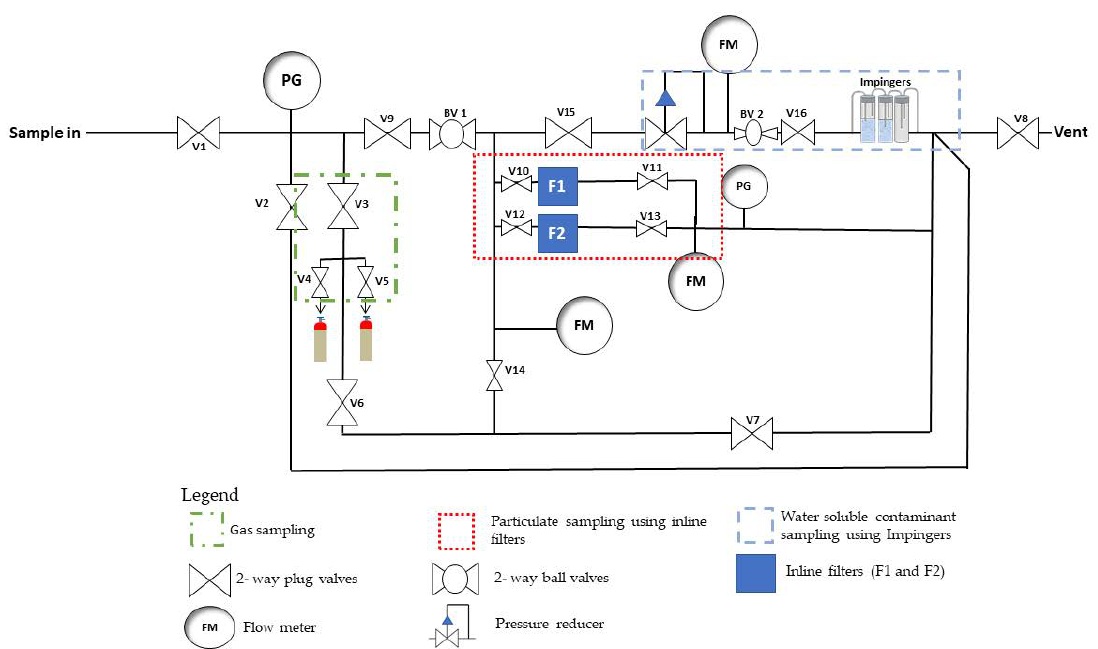
Figure 1. Hydrogen from SMR was sampled at a 15 bar sampling point after the Pressure Swing Adsorption (PSA) stage. Hydrogen from the alkaline electrolyser was sampled at a 9.8 bar sampling point after a de-oxygenation unit/dryer and hydrogen from the PEM water electrolyser was sampled at a 20 bar sampling point after Temperature Swing Adsorption (TSA).